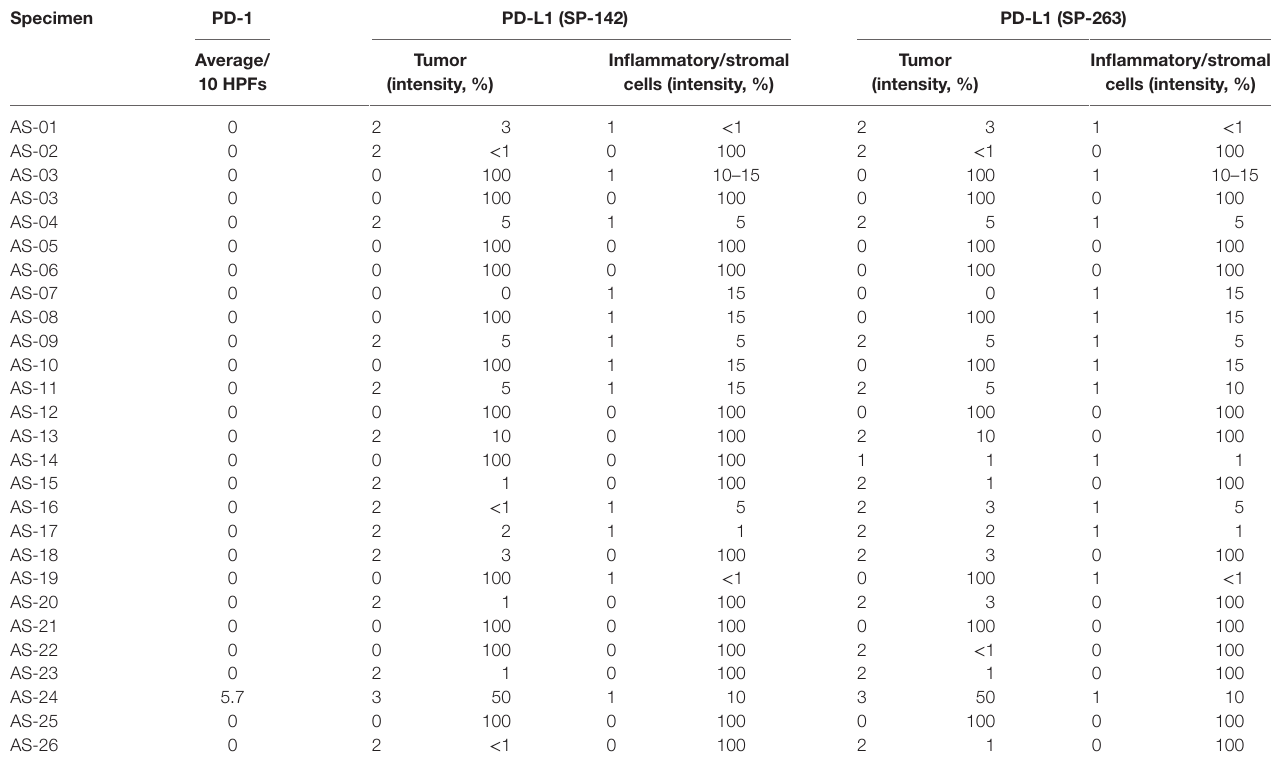
TaBle 2 | Programmed death-ligand 1 (PD-L1) and programmed death 1 (PD-1) immunohistochemical staining. specimen